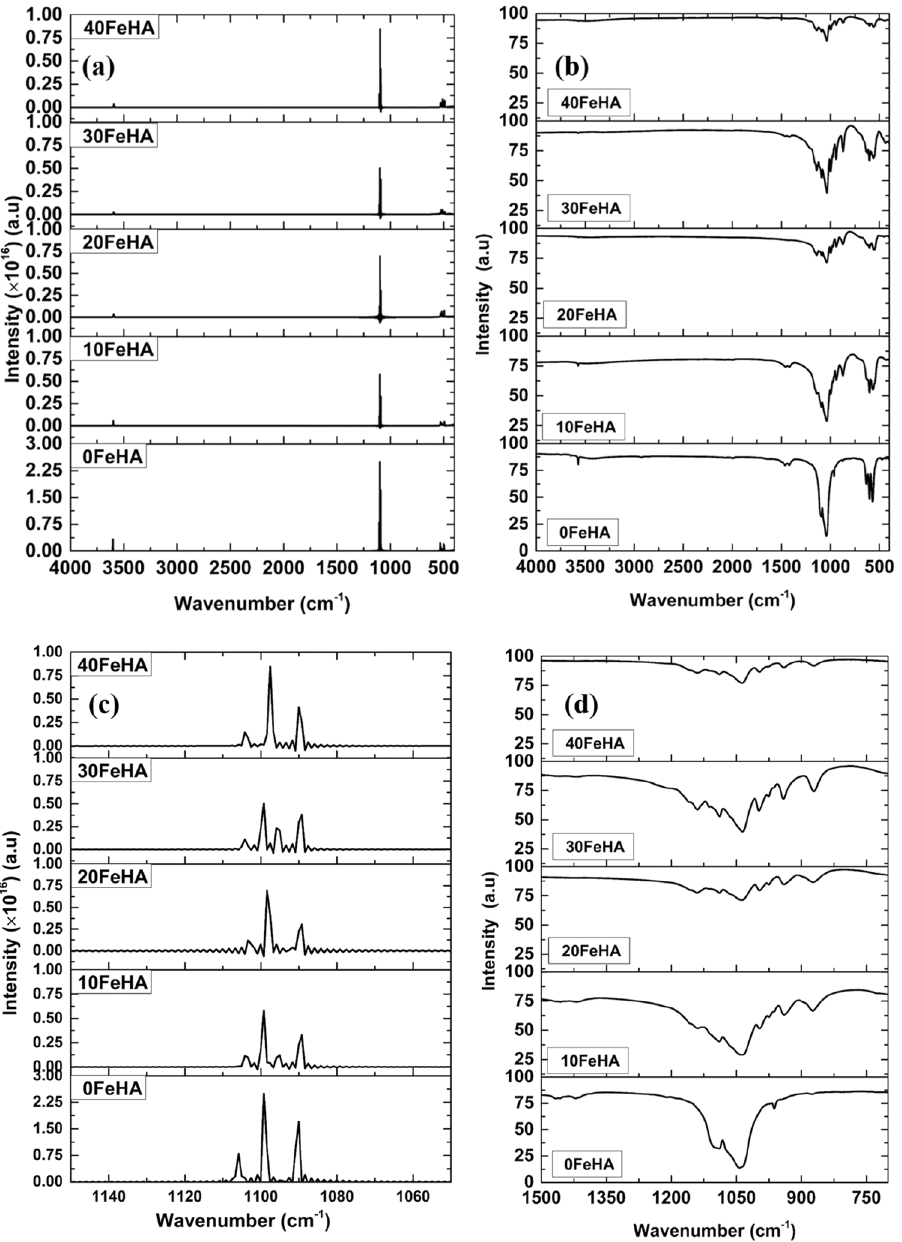
Figure 4. ( a ) Calculated and ( b ) experimental IR spectra different Fe-doped HA in the range of 4000–400 cm −1 . ( c ) Enlarged views of calculated IR spectra between the range of 1150–1050 cm −1 and ( d ) Experimental IR spectra in the range of 1500–700 cm −1 . A larger area has been enlarged in ( d ) because of the experimental band broadening. Magnified views of ( e ) computed, and ( f ) experimental IR spectra in the range of 650–400 cm −1 Bands of ( g ) simulated and ( h ) experimental IR spectra in the range of 4000–3000 cm −1 are also presented. Experimental spectra are taken from our previous study 46 . (Sample designation: xFeHA means x mol% Fe 2+ - doped